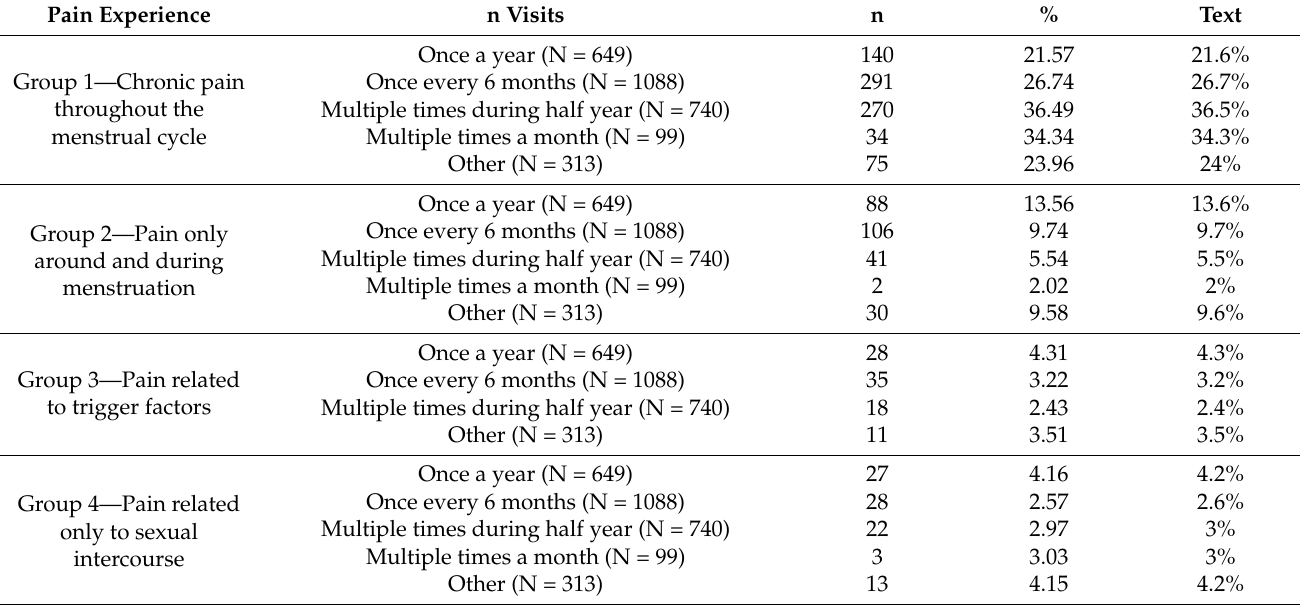
Table 4. Pain experiences in relation to gynecological appointments by the patients at the time of completing the